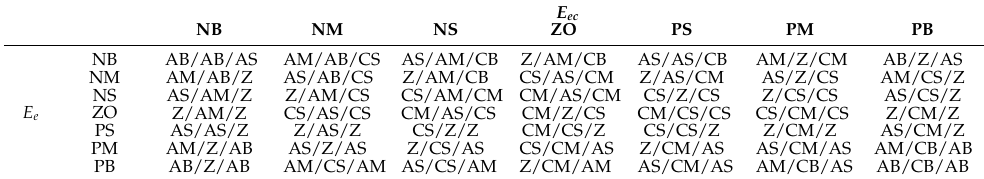
Table 4. Fuzzy control rules table of β p , β i , and β d .